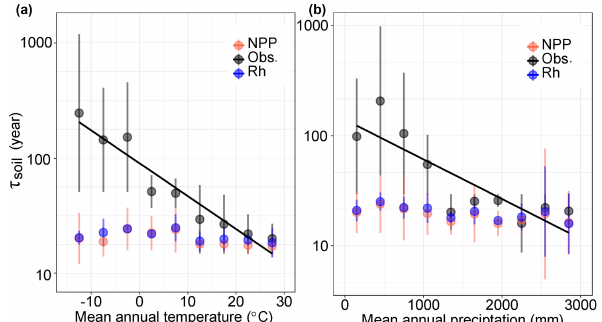
Figure 3. Relationships between SOC transit time ( τ soil ) and cli- mate factors in both observations and CIMP5 models. The black solid lines show the negative correlation between τ soil and (a) mean annual temperature and (b) mean annual precipitation. The black dots indicate the aggregated τ soil over each category of MAT ( y = − 5 . 47 x + 1971 . 5, r 2 = 0 . 49, P< 0 . 01) or MAP ( y = − 68 . 19 x + 1222 . 6, r 2 = 0 . 60, P< 0 . 01). The red and blue dots present the mean value of multiple models based on the ratios of carbon stock over NPP and R h , respectively.